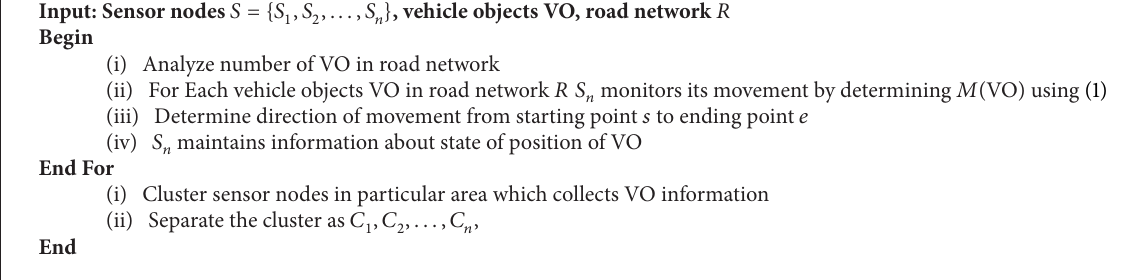
Algorithm 1: Adaptive node energy